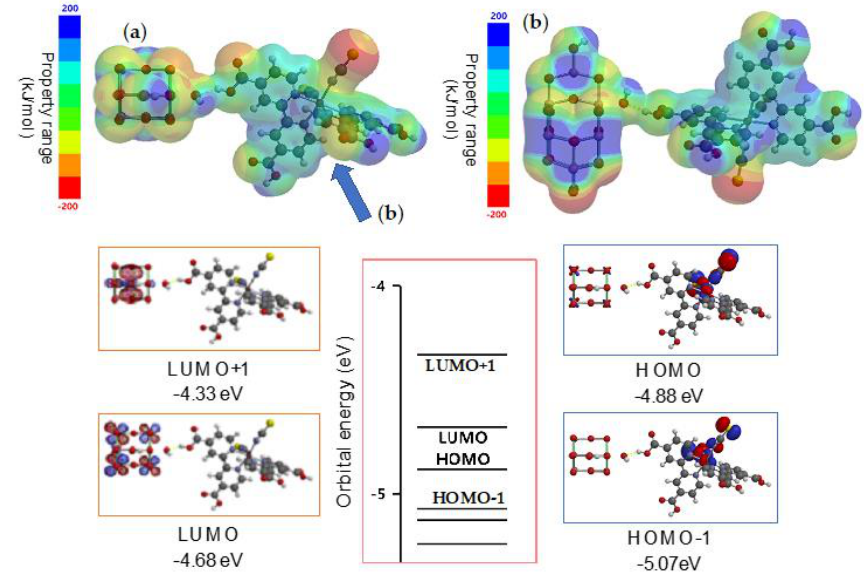
Figure 8. Electrostatic potential map (ESPM) of N3 (proton), adsorbed TiO 2 anatase model of Ti 9 O 18 H and OH and N3 (proton) and electron energy structures with HOMO / LUMO configuration for ( a ): ( a ) view from top; ( b ) side view.